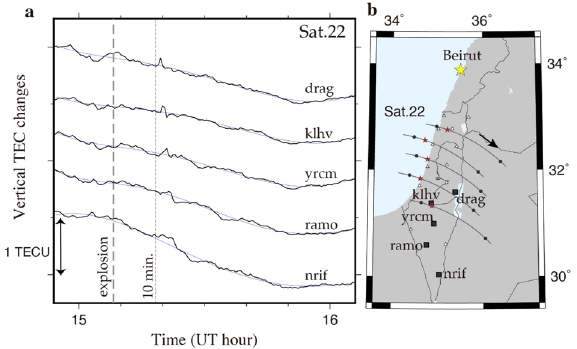
Figure 2. Time series of vertical TEC changes. ( a ) The VTEC change from GPS satellite 22 at stations darg, klhv, yrcm, ramo and nrif (squares in b ) over 14:54–16:06 UT on August 04, 2020. The dashed vertical line represents the explosion time (15:08:18 UT). Ionospheric disturbances are seen shortly after the dotted line indicating 10 min after the explosion as the departure from the smoothed reference curves (best fit degree-5 polynomials, thin gray curves). ( b ) The trajectory of sub-ionospheric points (SIPs) calculated assuming the thin ionosphere at altitude 300 km, marked with solid circles (hourly time mark) and red stars (explosion time). Open triangles show other stations used to draw Fig. 3. This figure was generated using Generic Mapping Tools (version 5.2.1; URL: http://gmt.soest .hawai i.edu/).